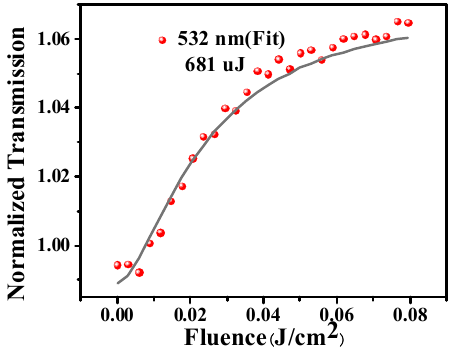
Figure 6. The optical limiting response at 532 nm.